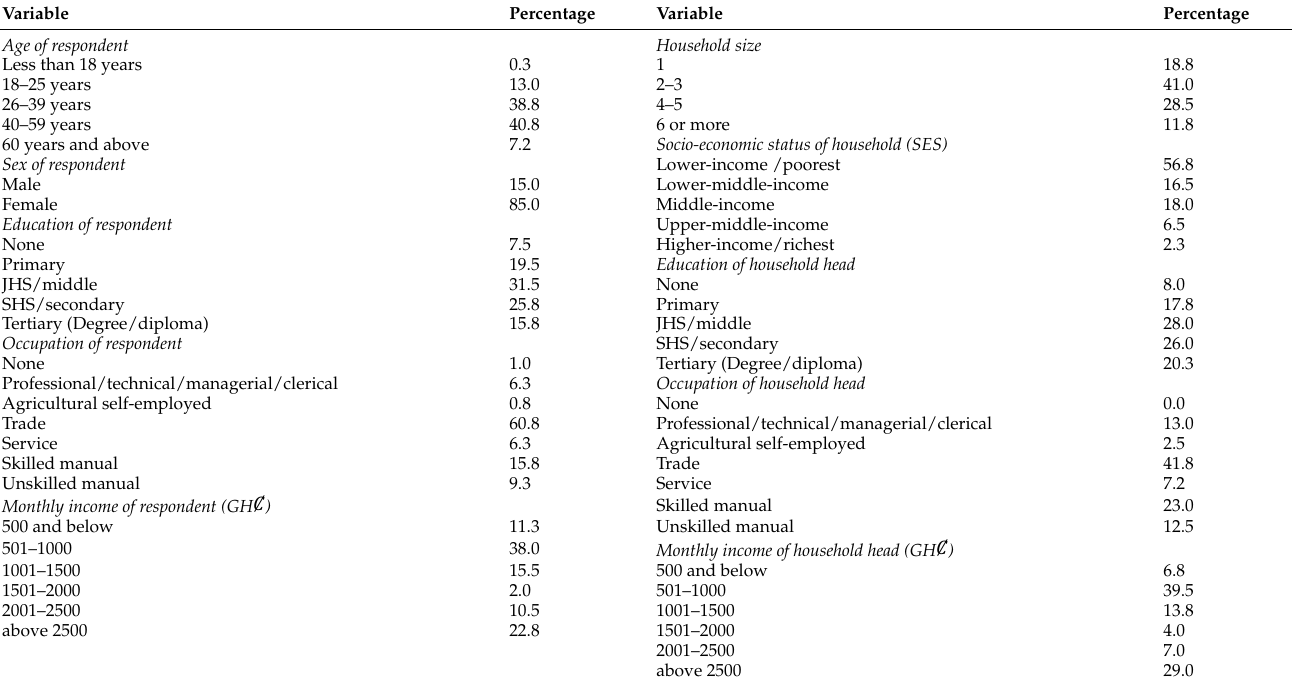
Table 1. Socio-demographic distribution of respondents and households.